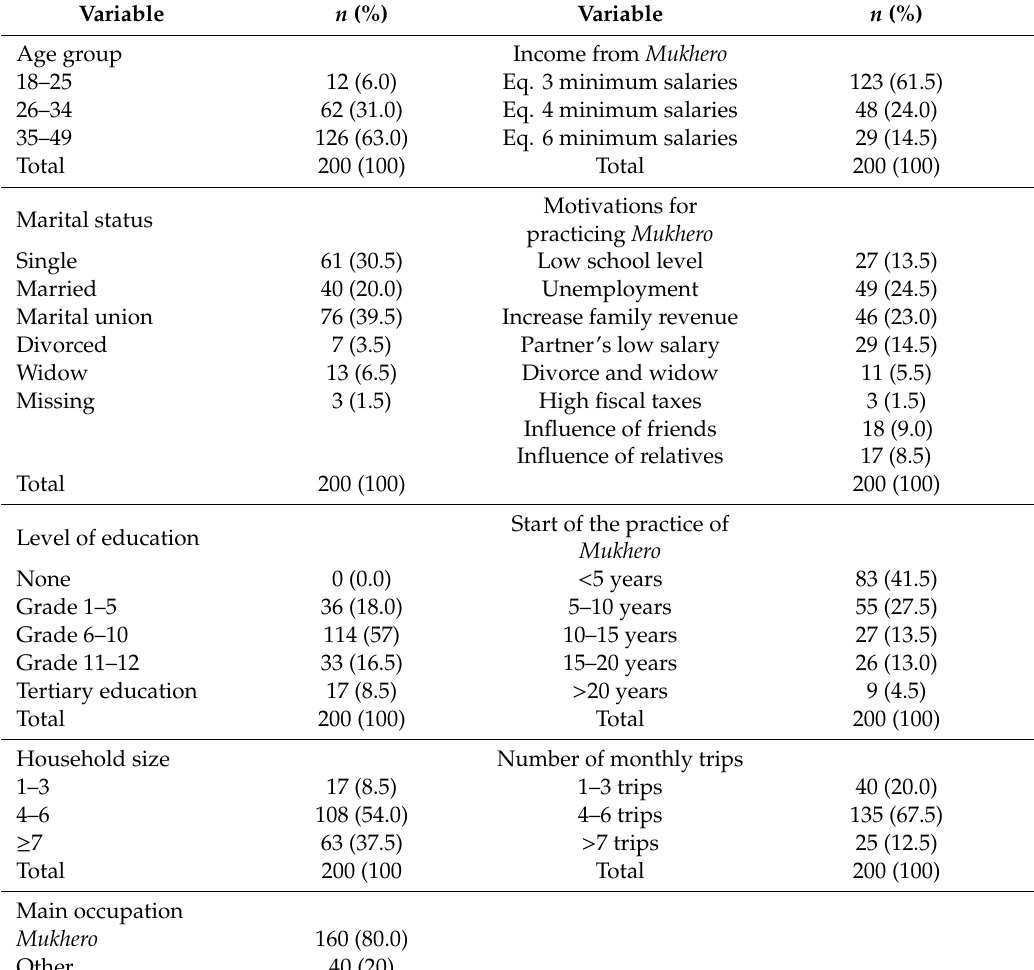
Table 1. Sociodemographic characteristics, motivation for the practice of Mukhero , and trips’